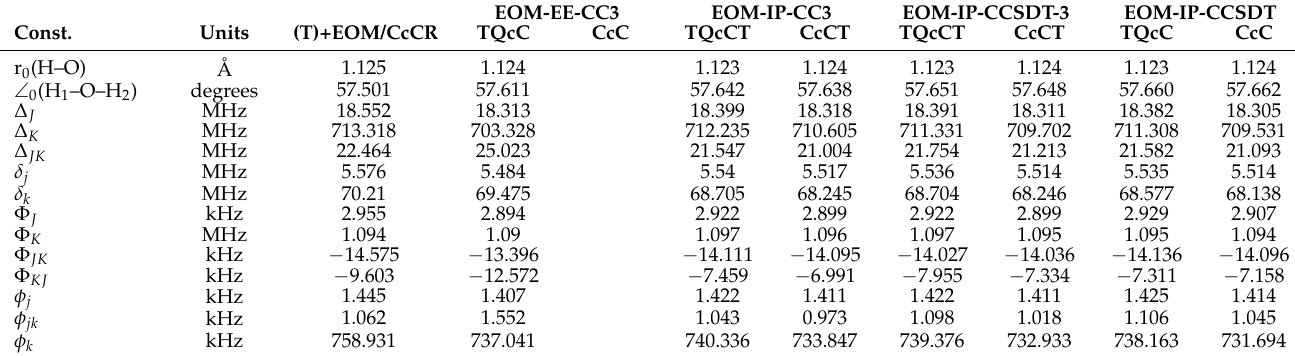
Table A4. ˜B 2 B 1 H 2 O + Distortion Constants and Geometrical Parameters.